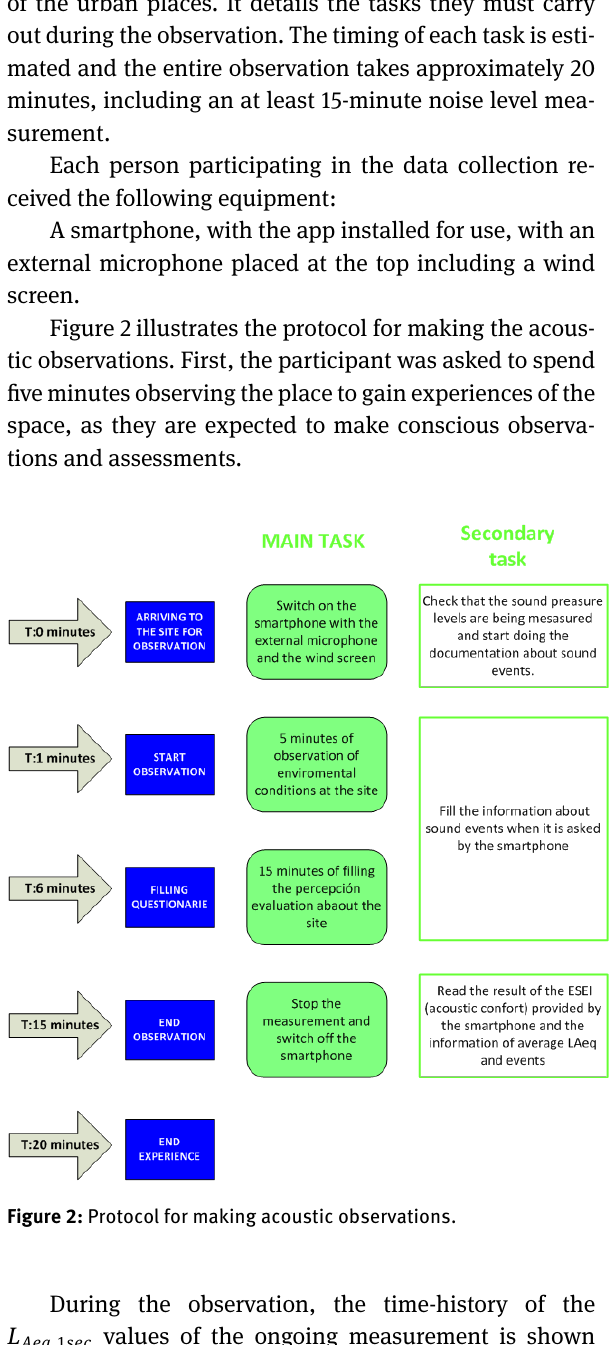
During the observation, the time-history of the L Aeq ,1 sec values of the ongoing measurement is shown on the smartphone screen. Sound events can appear at any moment during the observation on a pop-up message displayed on the screen each time a sound event is de- tected. When this occurs, the user is asked to identify their perception ( i.e. , pleasant or unpleasant) and the type of sound source in the